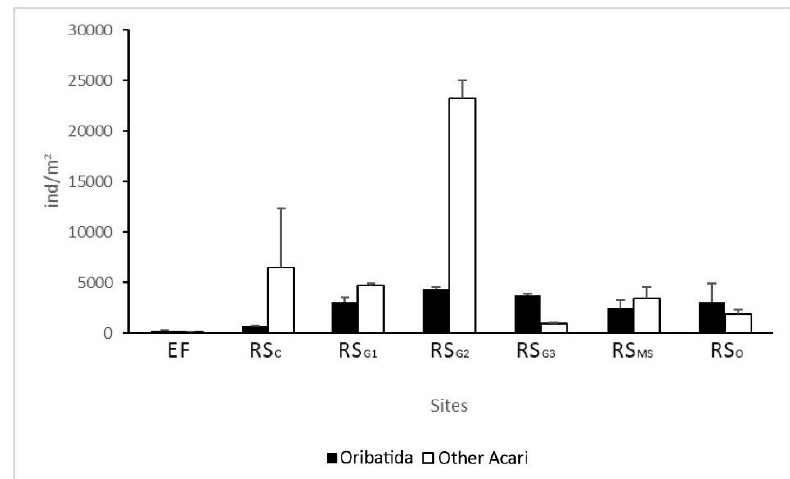
Figure 6. Average and standard error of the number of Oribatida and others Acari (ind./m²) found in each site.